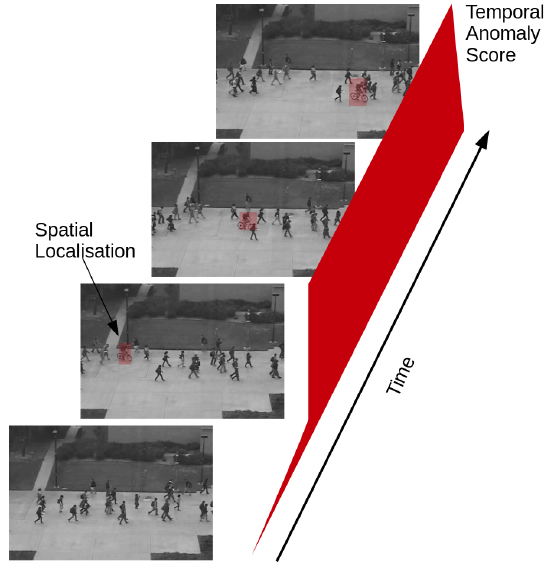
Figure 2. Visualizing anomalous regions and temporal anomaly